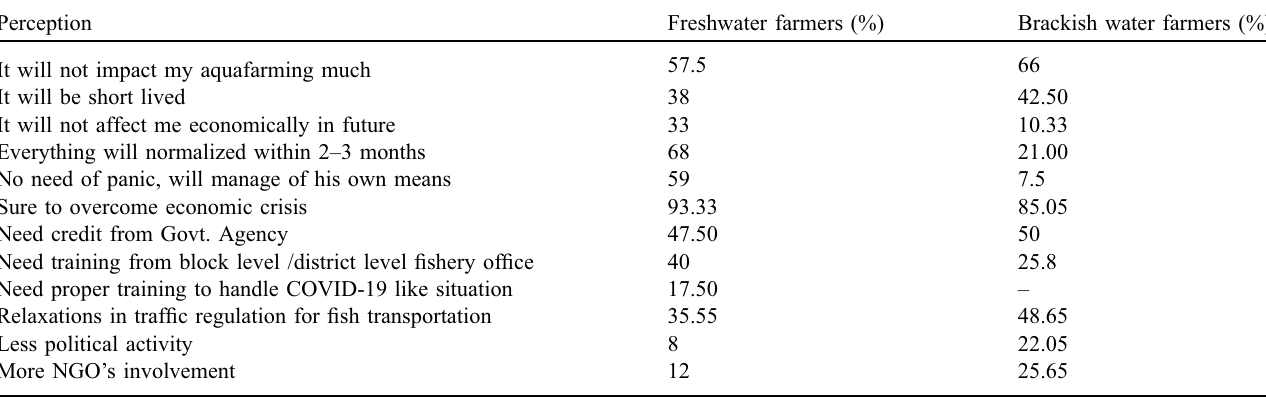
Table 2. Farmers ’ Perception in mitigating the crisis.